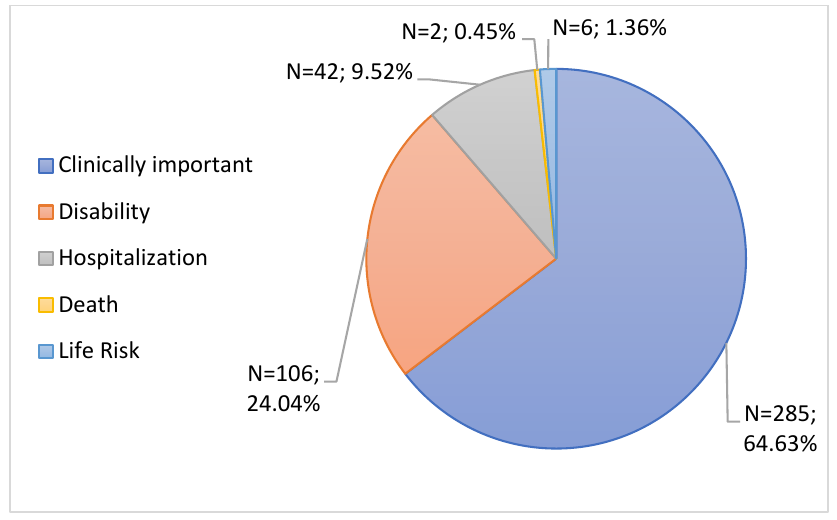
Figure 10. Characterization of serious notifications according to the seriousness criteria.